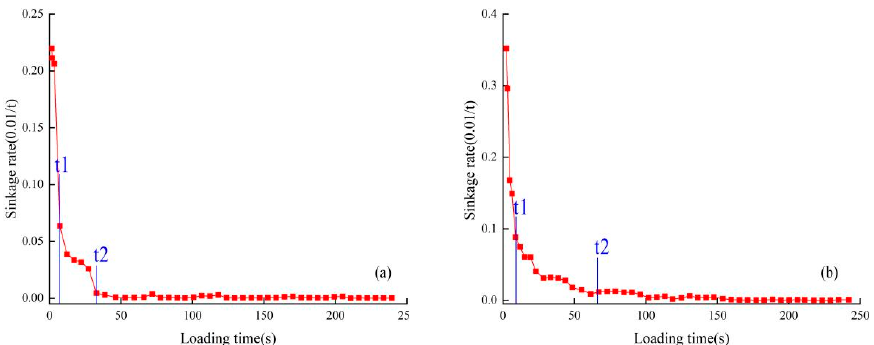
Figure 13. The curves of sinkage rate versus time for the simulated deep-sea sediments at pressures of ( a ) 5 kPa, and ( b ) 25 kPa. Here, t 1 is the transition point between the initial and secondary pressure– sinkage stages, and t 2 is the transition point between the secondary pressure–sinkage and stable creep stages.